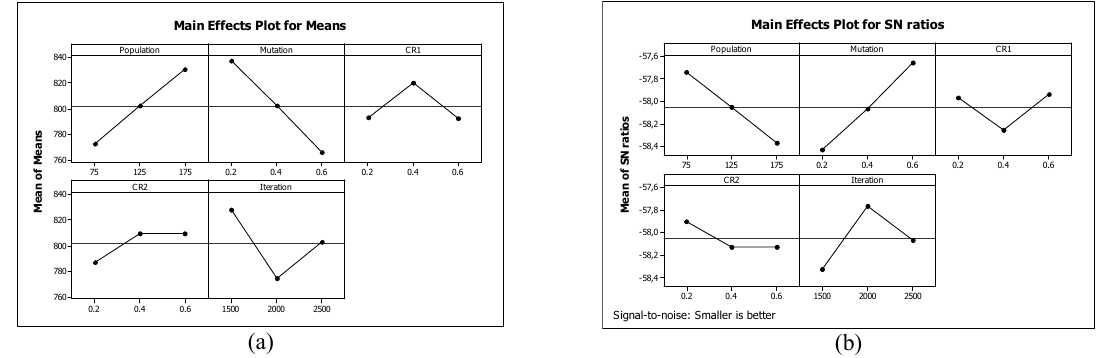
Fig. 8. Taguchi results for parameter tuning of GA (a) main effects and (b) SN ratios The Taguchi design is proposed for the IWO with the same problem as GA. The number of generations, initial number of weeds, maximum number of weeds, and S max , n, and σ final parameters with three levels are considered in the L27 design. The minimum number of seeds is considered to be 1 to give the worst individual of the colony an opportunity to produce seeds. The standard deviation initial value is accepted as 1 because it is the parameter that becomes meaningful compared with the standard deviation final value. The Taguchi results, presented in Figure 9, reveal that the number of initial weeds and maximum weeds and Smax parameters significantly affect the routing costs. The best parameter values of the IWO algorithm obtained from the SN ratio for the main effects diagram with the smaller-is-better condition were found, as follows: